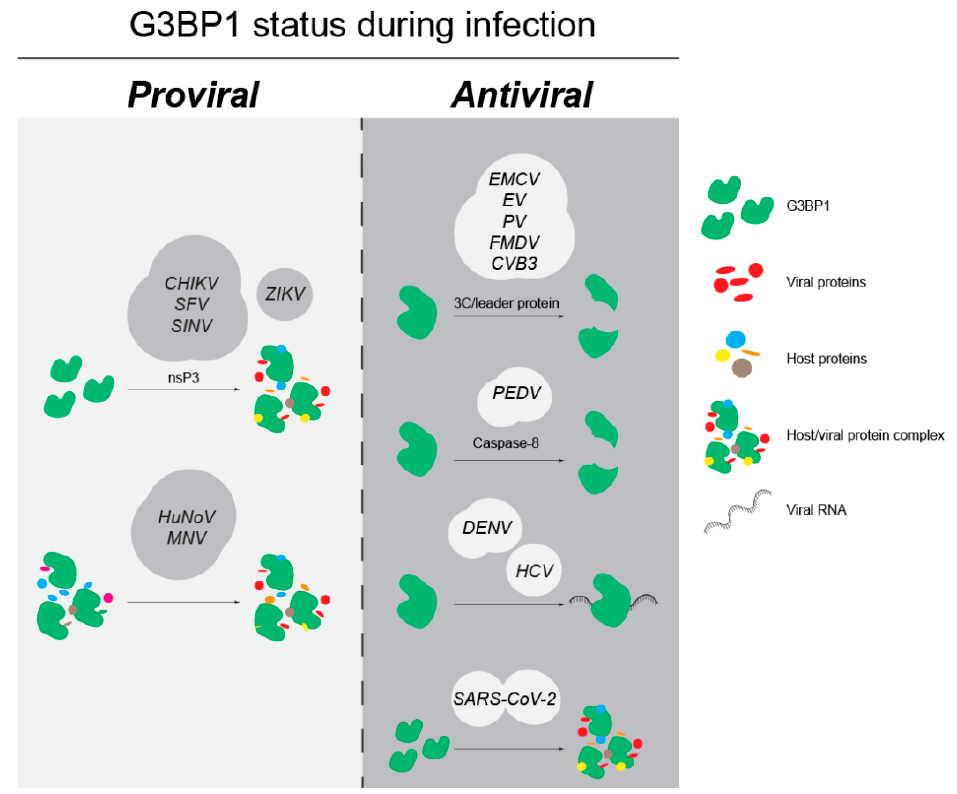
Figure 4. Strategies employed by different viruses to modulate G3BP1.